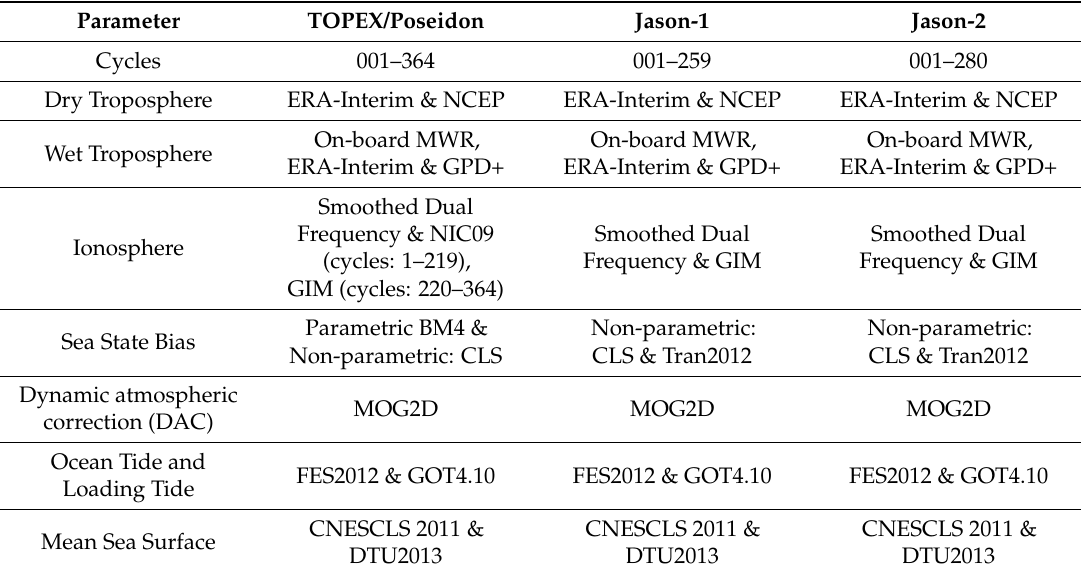
Table 1. Various range and geophysical corrections and mean sea surface models assessed in this study, aiming at determining sea level variability around the Indonesian